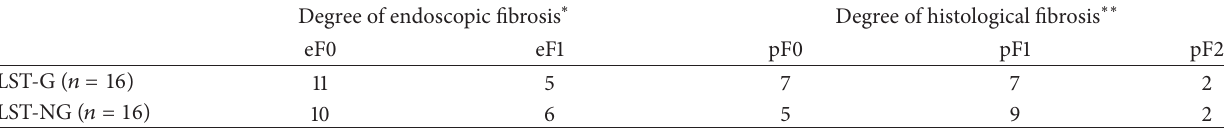
Table 5: Relationships between subtypes of laterally spreading tumor (LST) and degree of fibrosis. Degree of endoscopic fibrosis